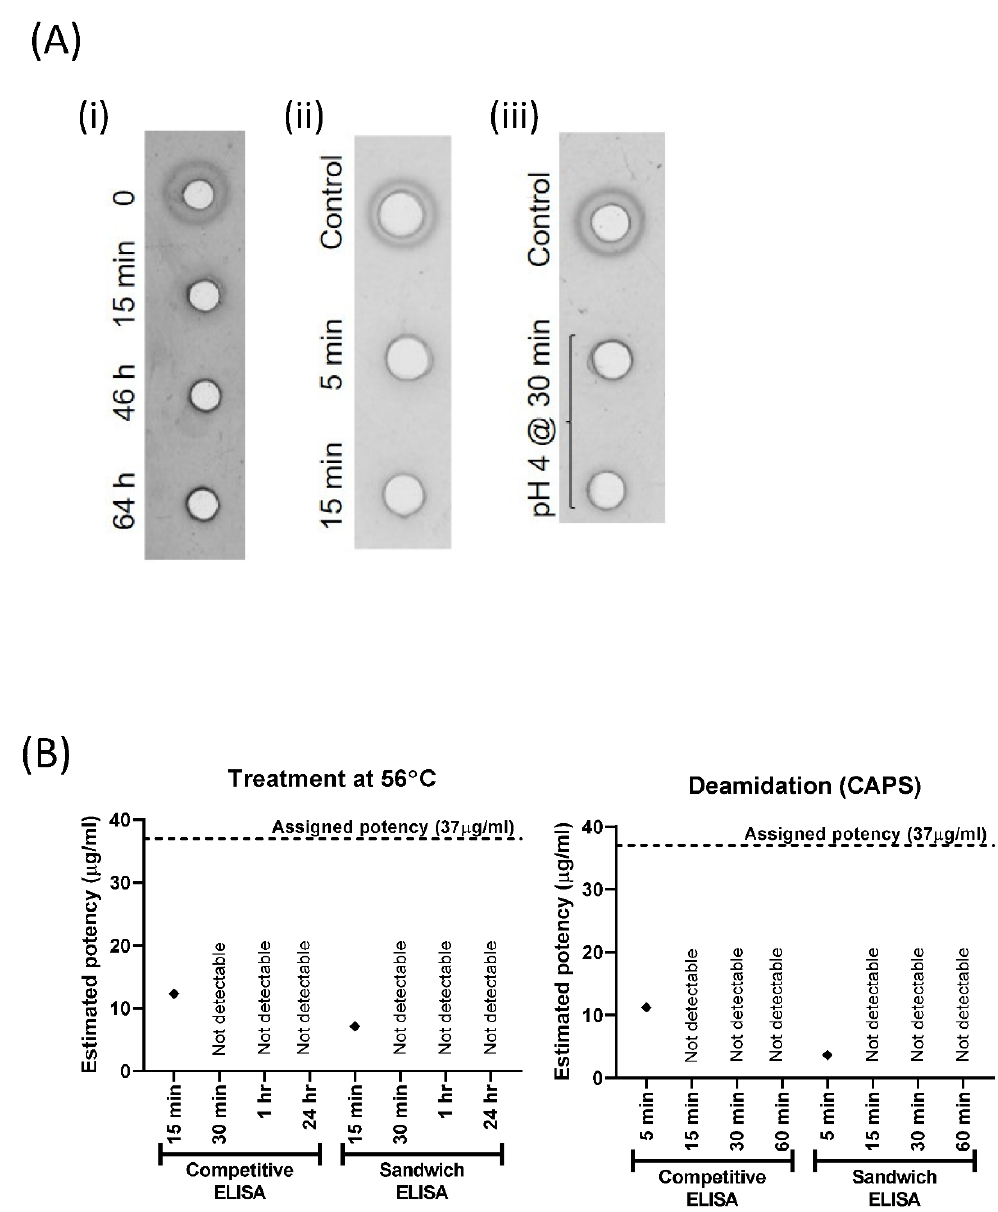
Figure 3. Forced degradation. ( A ) After treatment of antigen reagent ( i ) at 56 °C, ( ii ) by deamidation and ( iii ) by acid treatment, SRD precipitation zones were only present at timepoint 0 ( i ) or in untreated controls ( ii , iii ) in SRD assays. ( B ) Estimated potency graphs from ELISA assays after forced degradation at 56 °C or by deamidation.